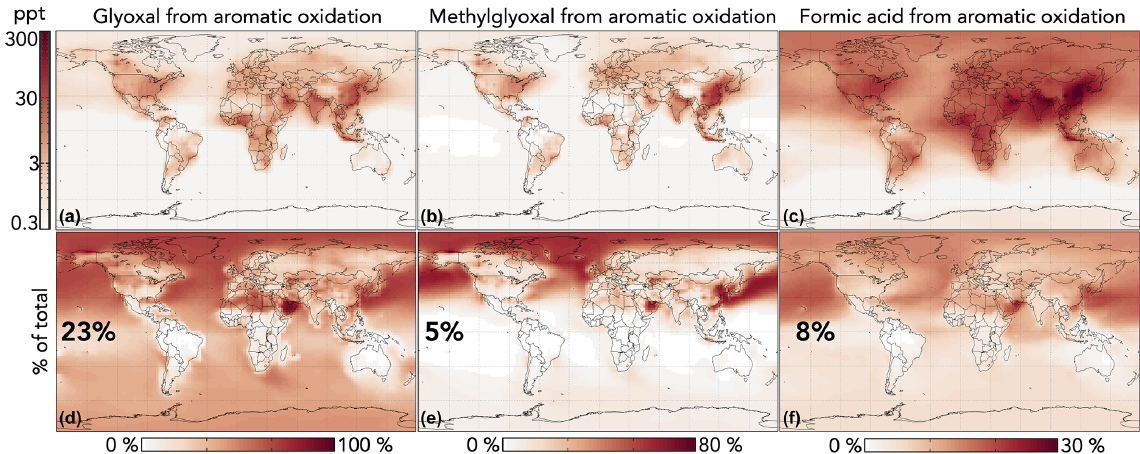
Figure 10. Effects of GC13 aromatic chemistry on glyoxal, methylglyoxal, and formic acid concentrations in GEOS-Chem. Panels (a) – (c) show absolute differences in annual mean concentrations below 1km altitude between GEOS-Chem simulations with GC13 aromatic chemistry and with no aromatic chemistry. Panels (d) – (f) show the percentage contributions of aromatic chemistry to the total model con- centrations of the three species. Inset numbers are global percentages. The color scales are logarithmic for panels (a) – (c) and linear for panels (d) – (f) .